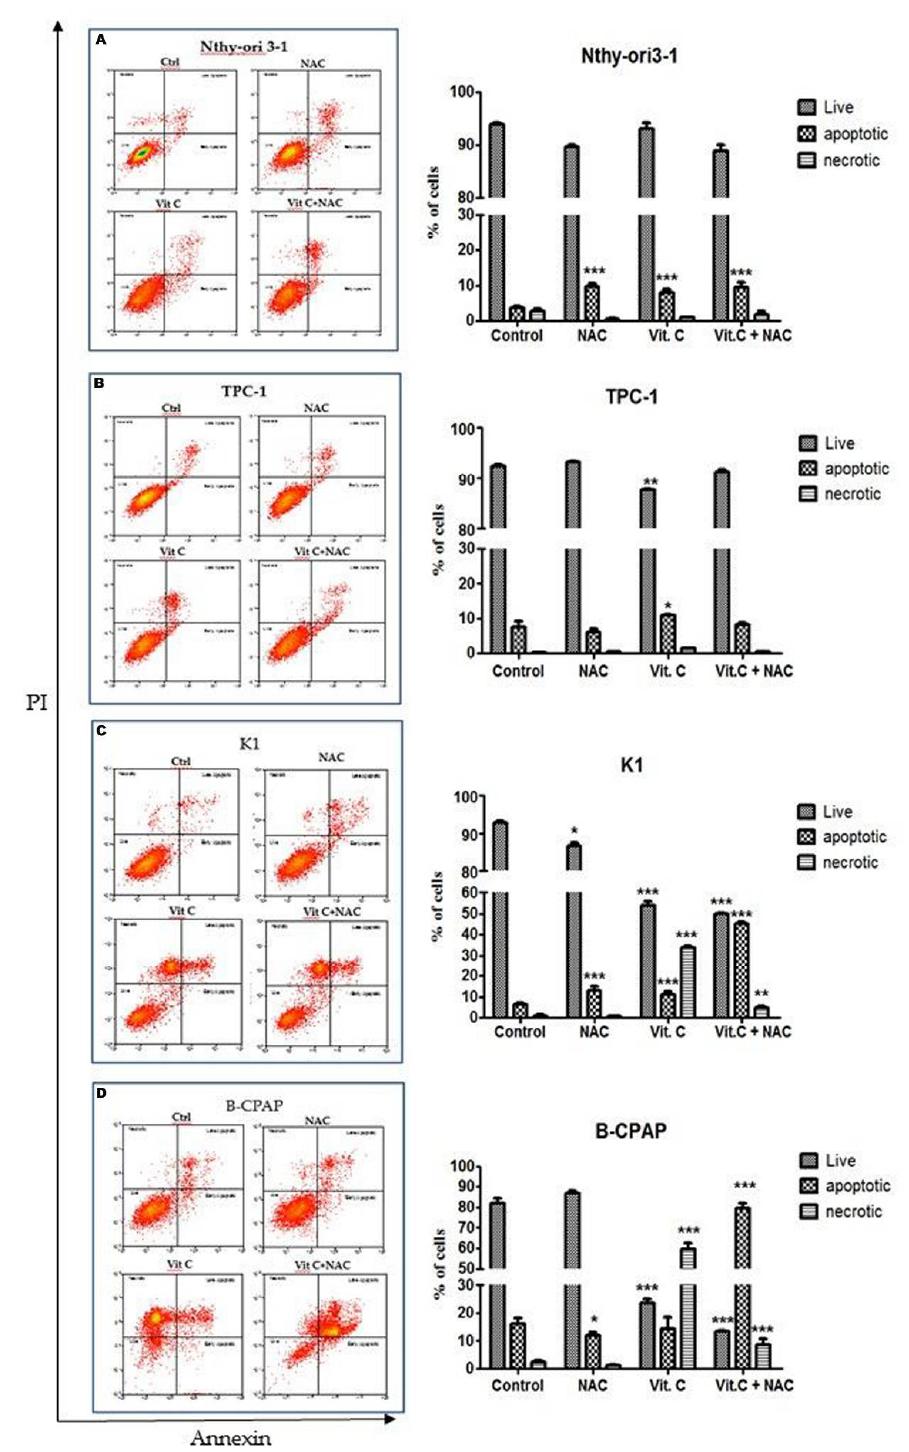
Figure 5. Percentage of live, apoptotic, and necrotic cells measured by flow cytometry using the PI- annexin V assay. All cell lines were exposed to 5 mM of vitamin C or NAC (10 mM) or a combination of both agents for 48 h. Dot plots showing cell death in Nthy-ori3-1 ( A ), TPC-1 ( B ), K1 ( C ), and B-CPAP cells ( D ). Pictures are representative of three experiments. Bar graphs represented the percentage of live, apoptotic (early apoptotic and late apoptotic cells), and necrotic cells. Data are expressed as Mean of % cells ± SD. All experiments were performed three times independently, each time in triplicate, to confirm the results. Statistical analyses were performed by Student t -test. Statistical differences vs. control are expressed with superscript symbols: * p < 0.05; ** p < 0.01; *** p <